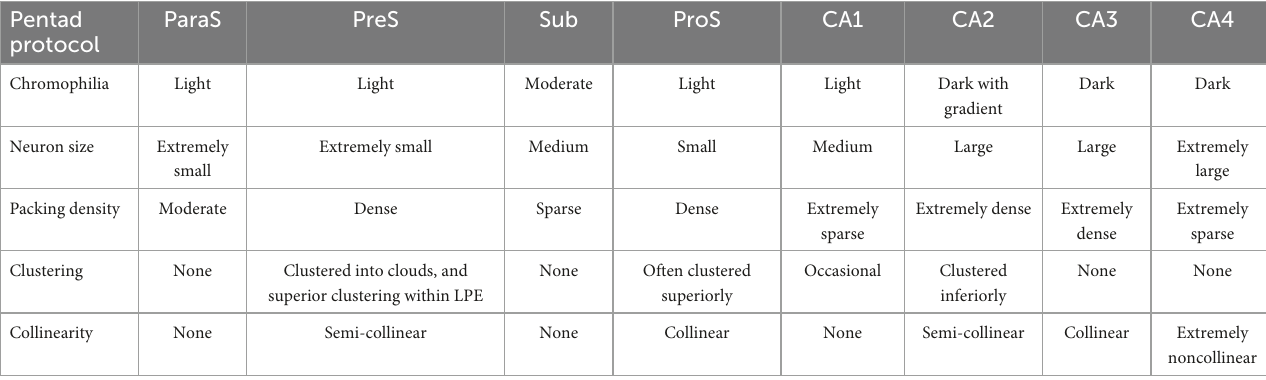
TABLE 4 Our hippocampal pentad protocol findings summarized for each subfield based on Nissl staining. Pentad